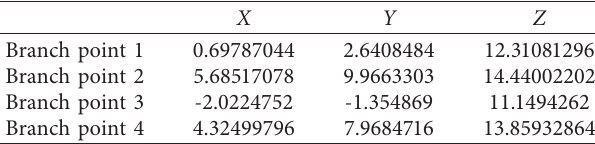
Table 5: Bifurcation point